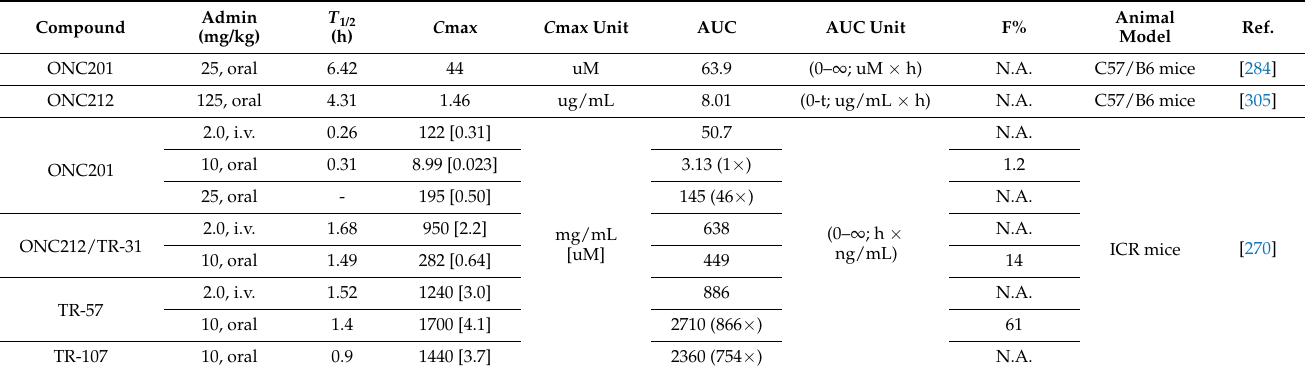
Table 3. Pharmacokinetic analysis of select ClpP